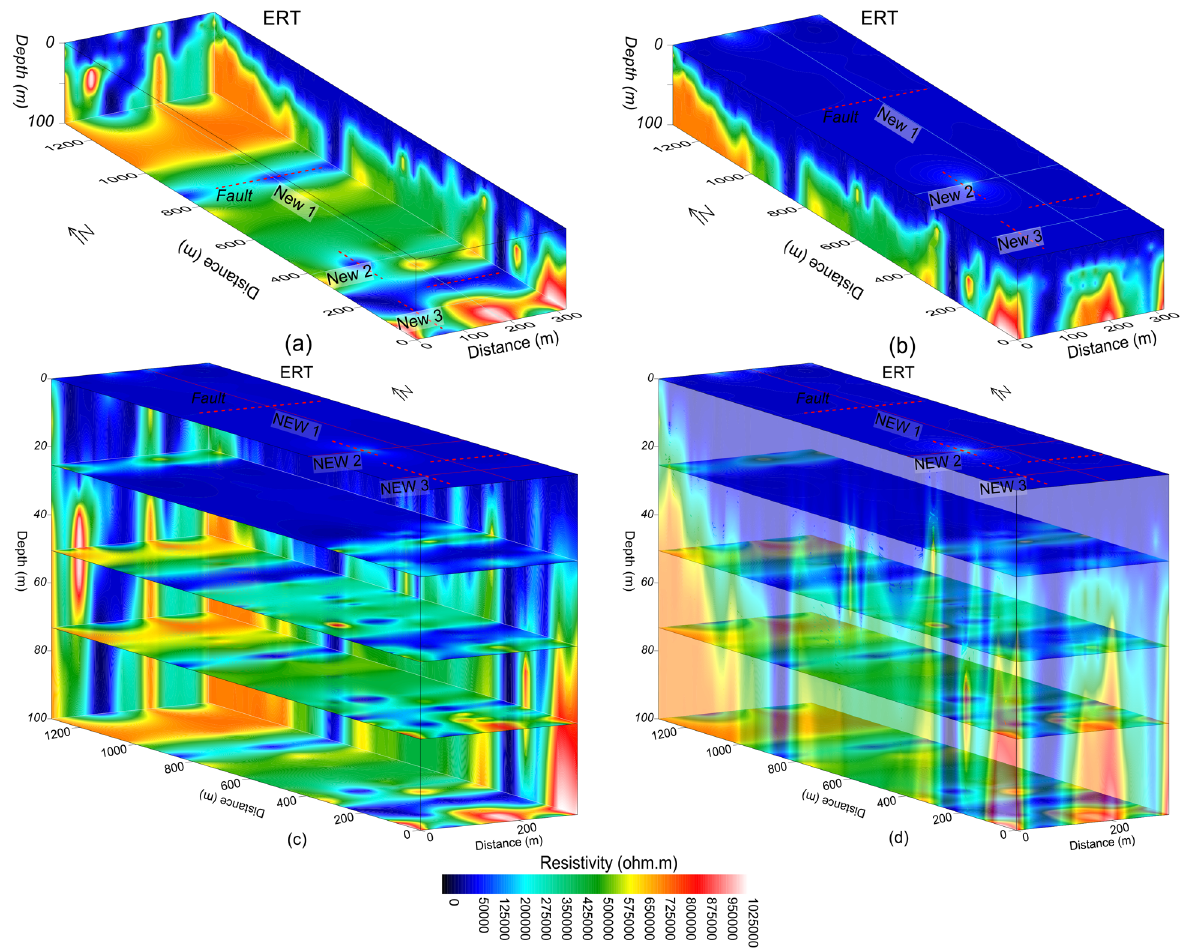
Figure 6. Resistivity imaging (increasing from dark blue to red white on a color scale) along three profiles (red lines) including faults (dashed red lines) for: ( a ) the inner view of 3D ERT, ( b ) the outer view of 3D ERT, ( c ) different depths from ground surface to 100 m with 3D ERT (inner view), and ( d ) different depths from ground surface to 100 m with 3D ERT (outer